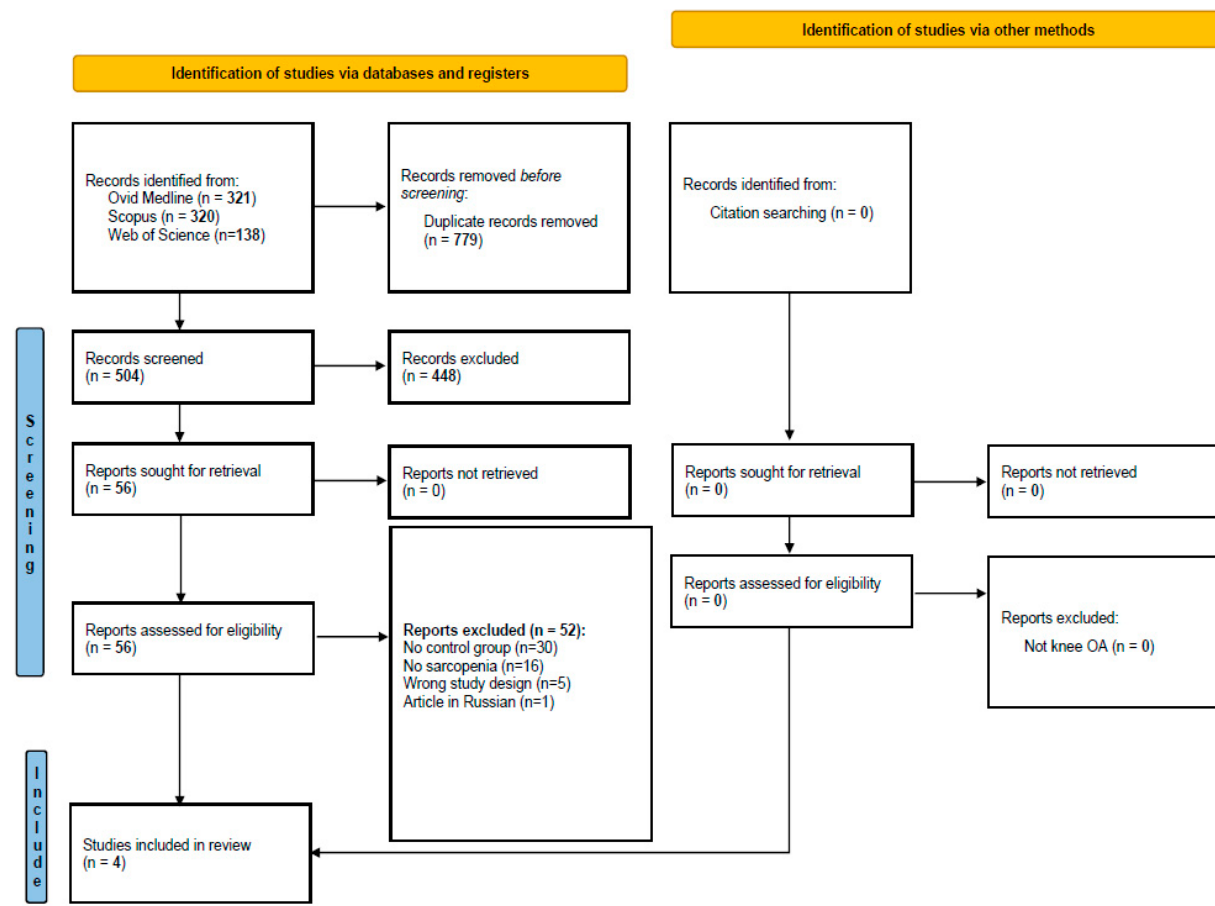
Figure 1. PRISMA flowchart.